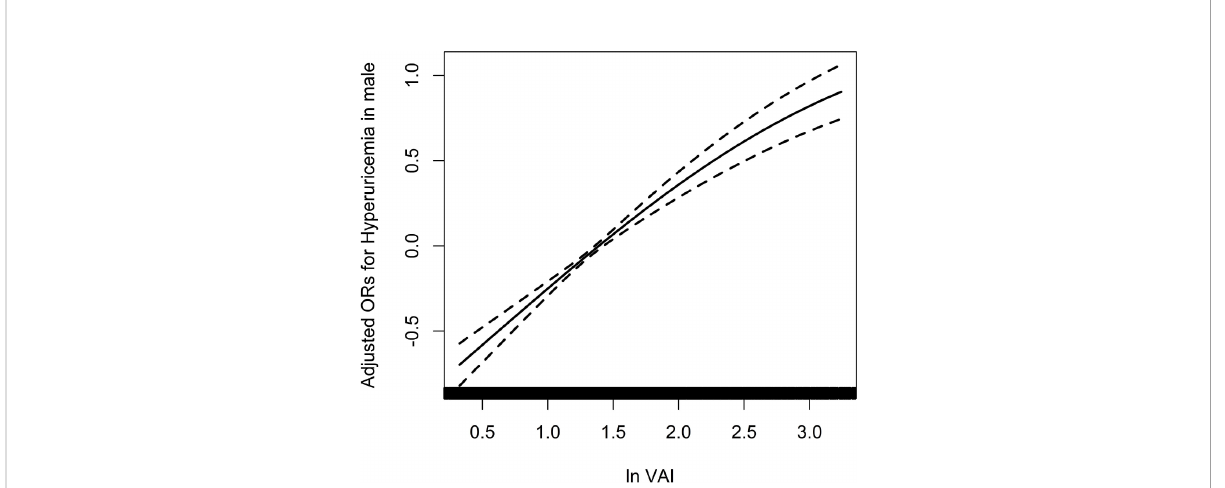
FIGURE 1 Association between ln VAI and hyperuricemia in males adjusted for age, smoking, drinking, BMI, SBP, DBP, TC, LDL-C, Hcy, eGFR, anti- hypertensive drugs, glucose-lowering drugs.